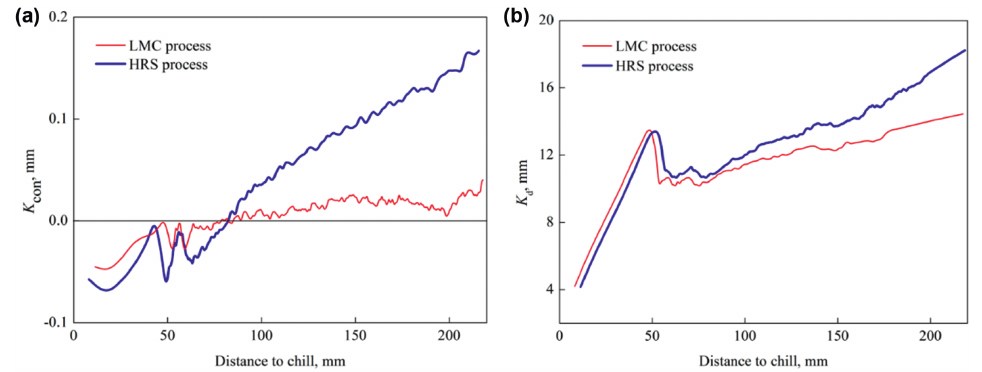
Figure 5: Mushy zone variation with distance to chill: (a) concavity and (b) length.